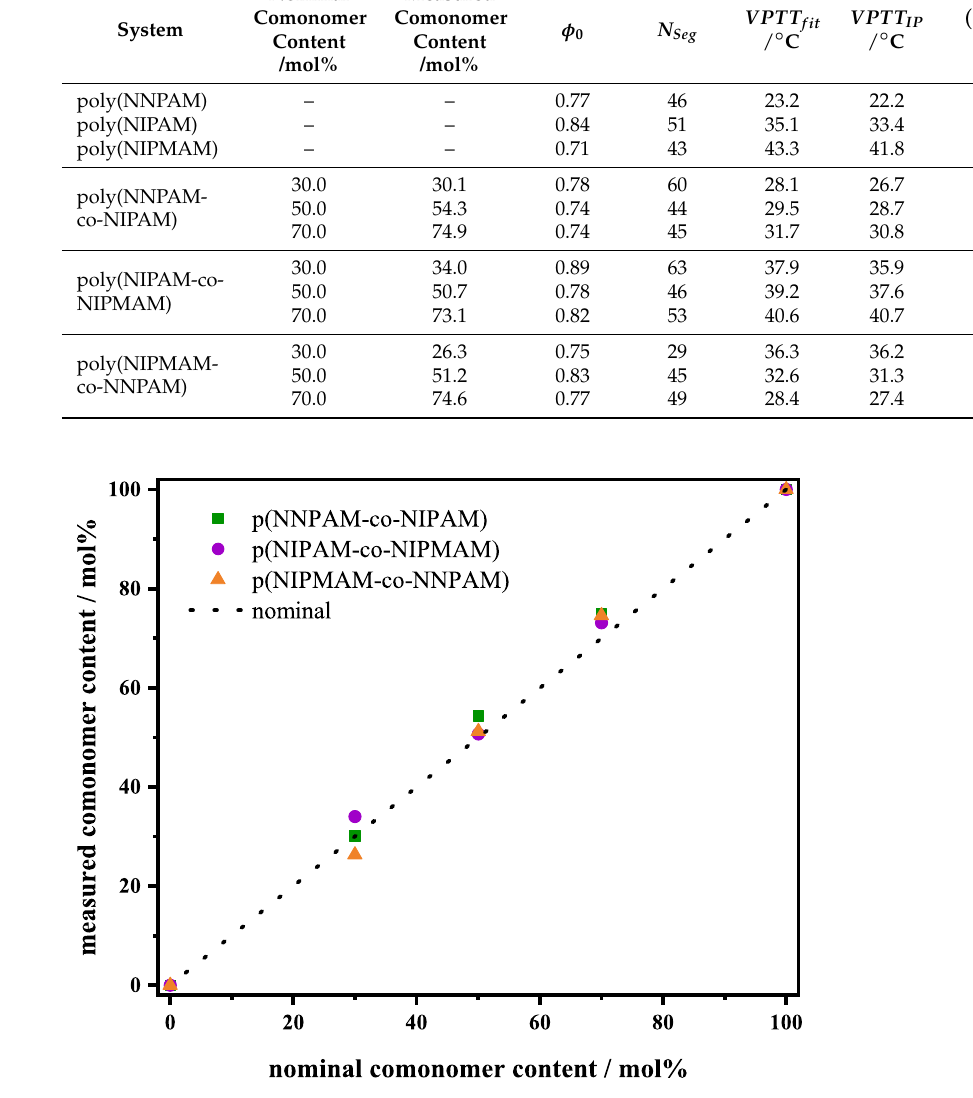
Figure 1. Measured comonomer content vs. nominal comonomer content for poly(NNPAM-co- NIPAM) (squares), poly(NIPAM-co-NIPMAM) (circles) and poly(NIPMAM-co-NNPAM) (triangles) microgels. The copolymerization ratio was calculated from the 1 H-NMR spectra. The dashed line represents the correlation between nominal monomer feed and measured real incorporated comonomer